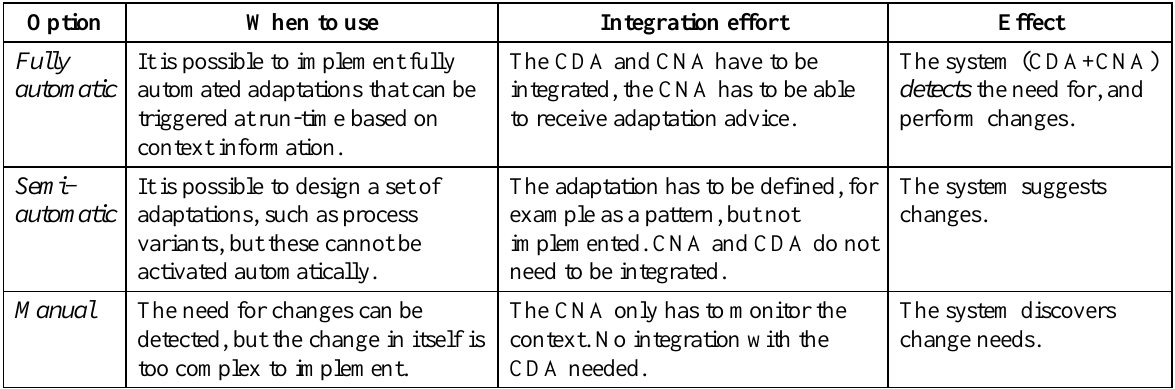
Table 5. Summary of run-time adaptation